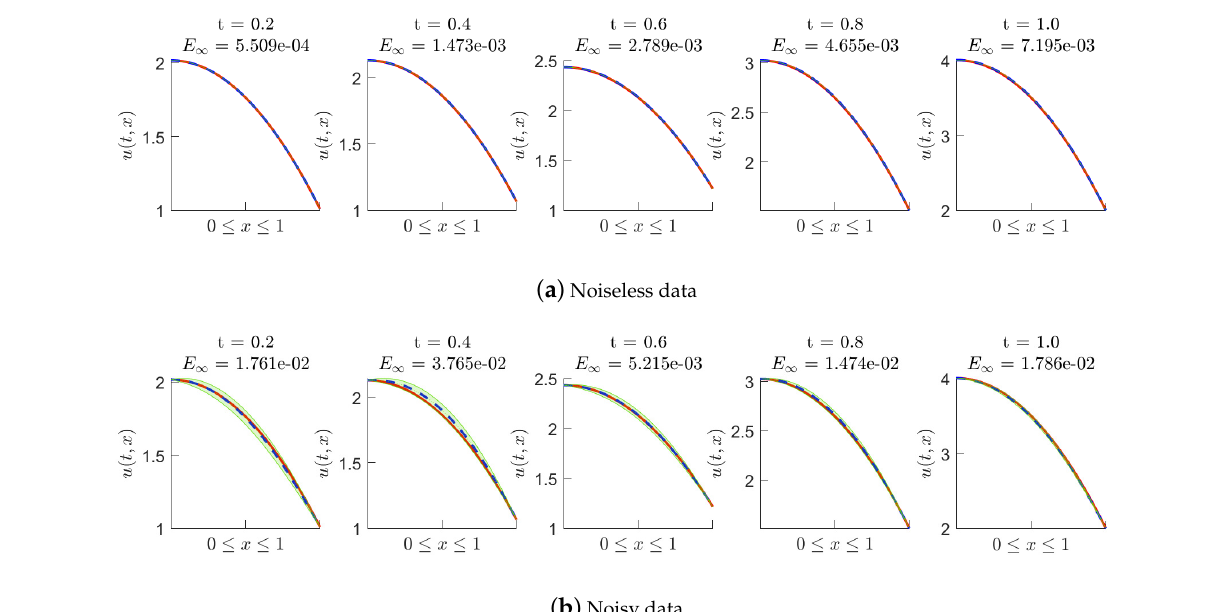
Figure 5. Integro-differential equation: the posterior distribution of the predicted solution at different time nodes, where ∆ t = 0.01. Noiseless data and noisy data are used,